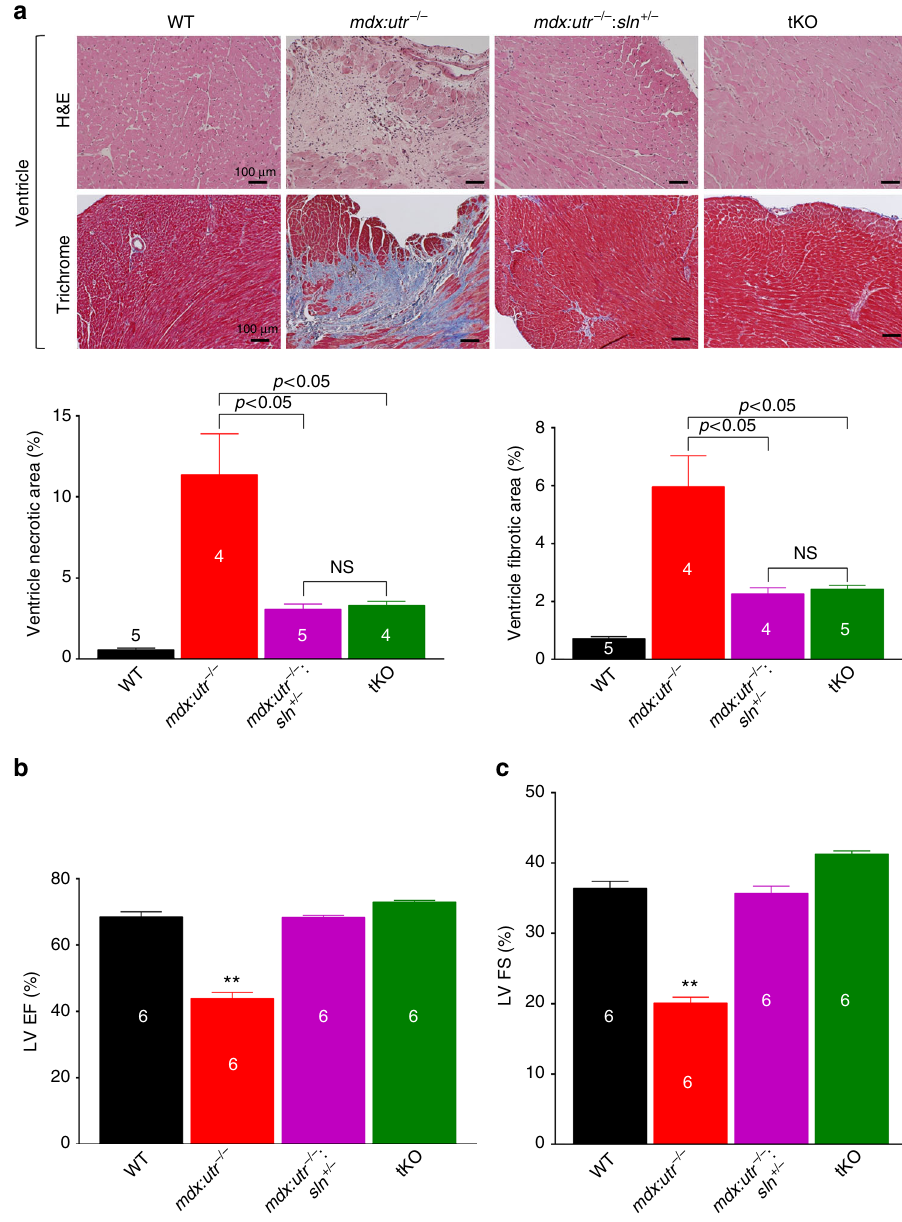
Fig. 5 Ablation of SLN expression prevents cardiomyopathy in mdx:utr − / − mice. All cardiac studies are performed in 3 – 4 month old mice. a Representative H&E and Masson ’ s trichrome stained ventricular tissue sections. Original magni fi cation is ×10. Scale bar = 100 μ m. Bar graph indicate that reduction or ablation of SLN signi fi cantly reduced fi brosis and necrosis in the mdx:utr − / − hearts. The n number for each group and the p values ( t -test with Welch ’ s correction) are shown within the graph. Data are presented as mean ± SEM. b , c Echocardiographic measurements demonstrate that the LV ejection fraction (EF) and fractional shortening (FS) are restored to normal values in the mdx:utr − / − :sln + / − and tKO mice. ** p < 0.0001 vs. other groups; n = 6 per group. Data are presented as mean ± SEM ( t -test with Welch ’ s